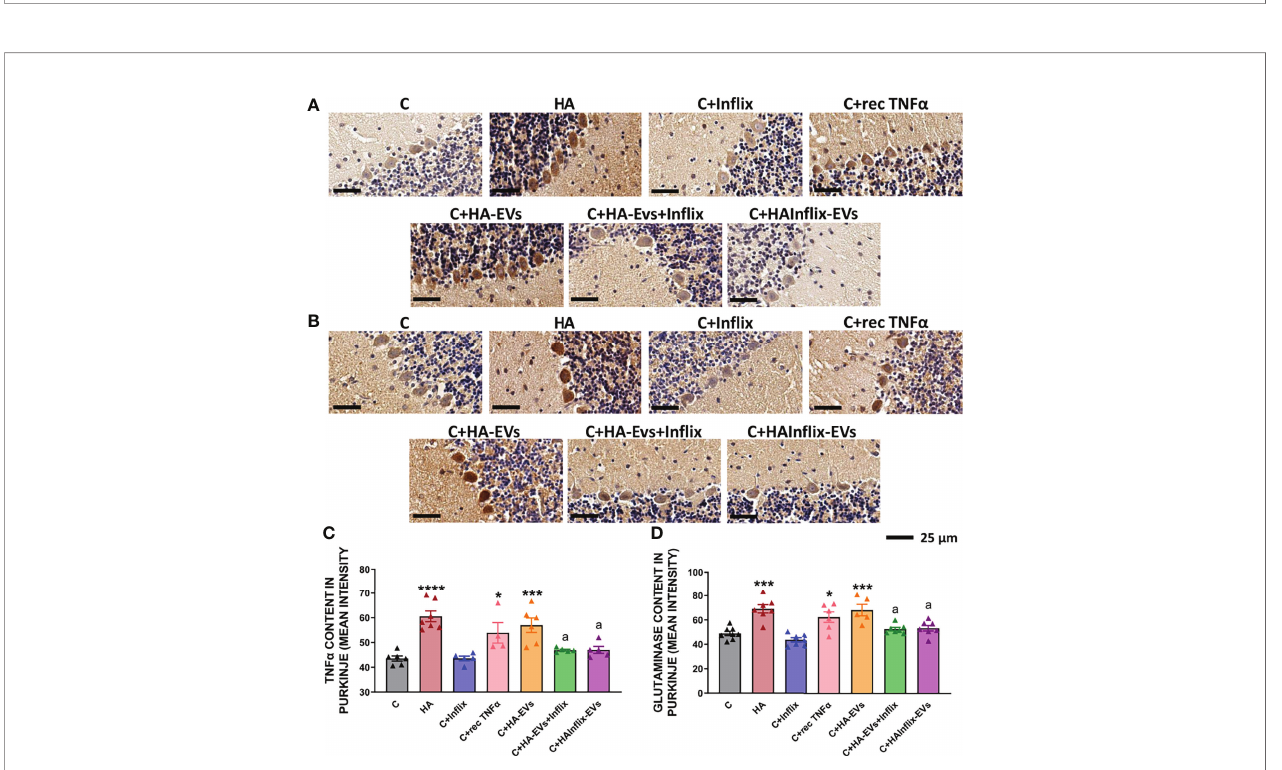
FIGURE 6 | Extracellular vesicles from hyperammonemic rats increase TNF a and glutaminase content in Purkinje neurons in cerebellar slices from control rats. Representative images of immunohistochemistry against (A) TNF a and (B) glutaminase, showing Purkinje neurons of the cerebellum. Content of (C) TNF a (n=4-7) and (D) glutaminase (n=5-8) in Purkinje neurons, measured as mean intensity. Sample size indicates number of animals. One-way ANOVA with Tukey post-hoc test was performed to compare all groups. Values are the mean±SEM. Values signi fi cantly different from controls are indicated by asterisk (*p<0.05, **p<0.01, ***p<0.001, ****p<0.0001) and values signi fi cantly different from C+HA-EVs group are indicated by a (a=p<0.05). Scale bar = 25 m m.